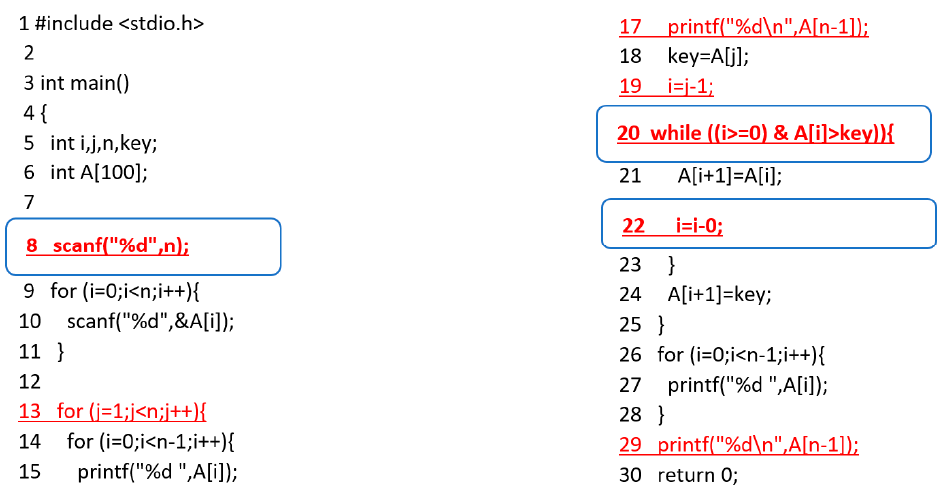
Figure 7. Syntax error assessment and detection for source code evaluated using LSTM-AttM.